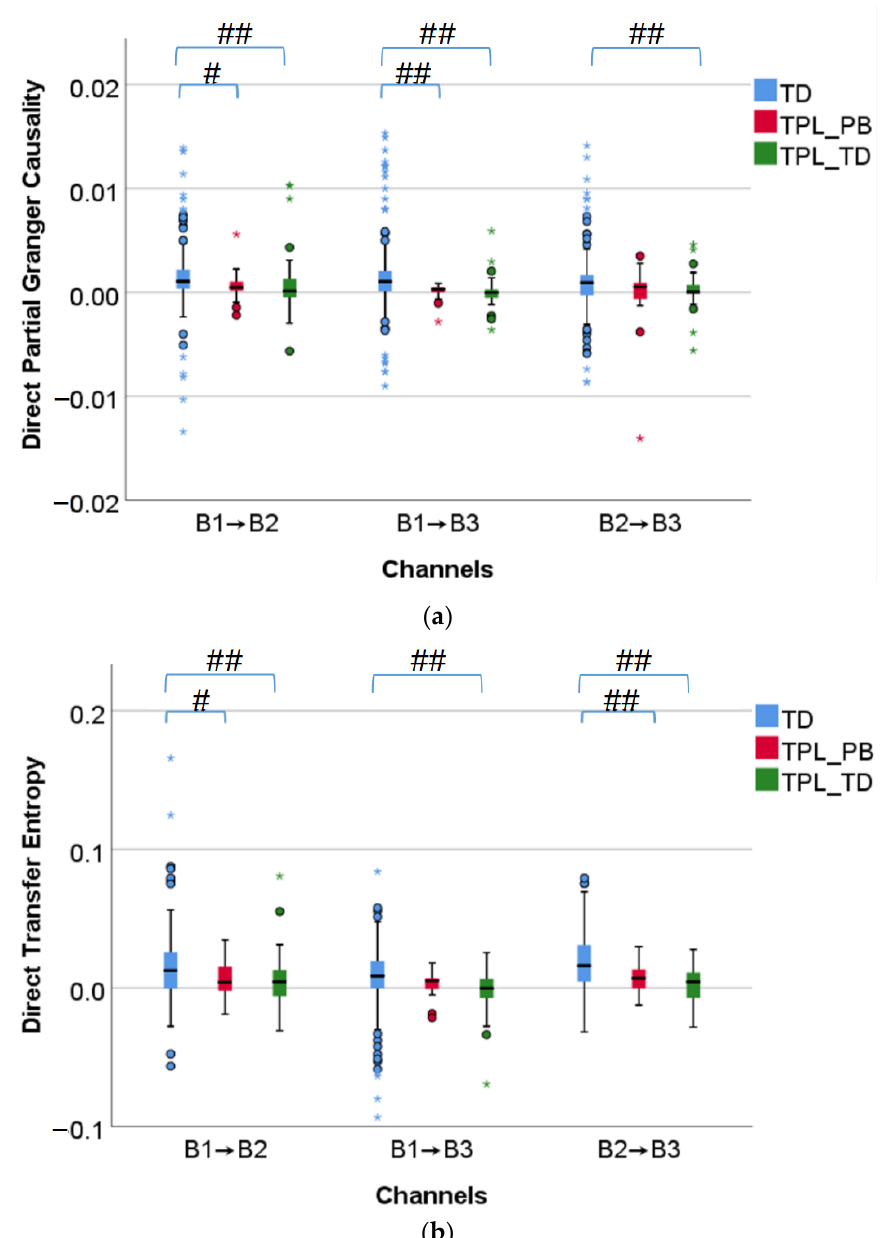
Figure 4. Comparison of information flow between TD, TPL_PB, and TPL_TD. #: p < 0.05, ##: p < 0.01, ○ : the moderate outlier, *: the extreme outlier. ( a ) Direct partial Granger causality; ( b ) Direct transfer entropy.